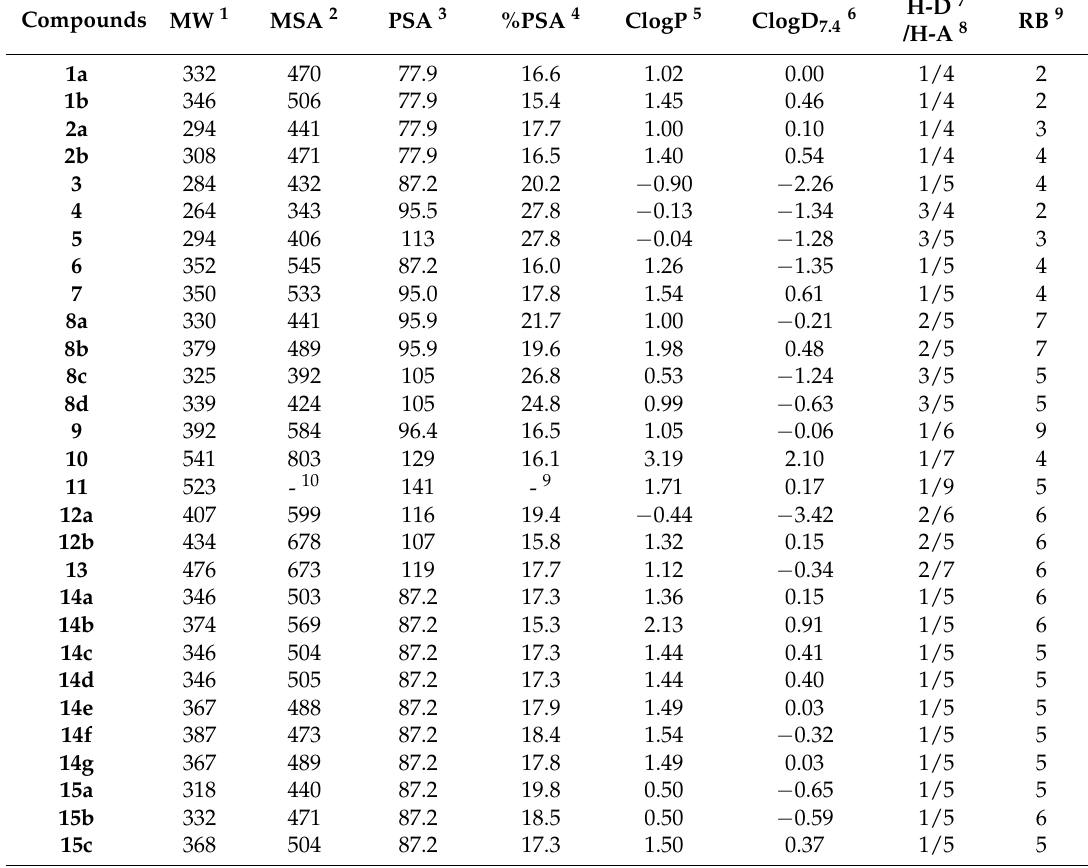
Table 3. Physiocochemical properties of all barbiturates (see Figure 2).